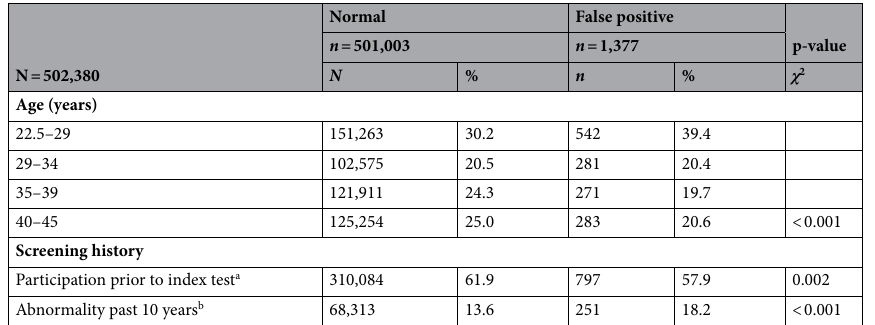
Table 1. Distribution of baseline data among normal and false positive participants at inclusion. Normal: defined as having an adequate cervical cytology result showing no dysplasia. False positive: defined as having an abnormal cervical cytology result showing high-grade cytological abnormalities with a subsequent biopsy with a normal or ‘cervical intraepithelial neoplasia grade 1’ result within 6 months. a Cervical cytology performed within 42 months prior to inclusion. b Any abnormal cervical results within the past 10 years prior to inclusion.